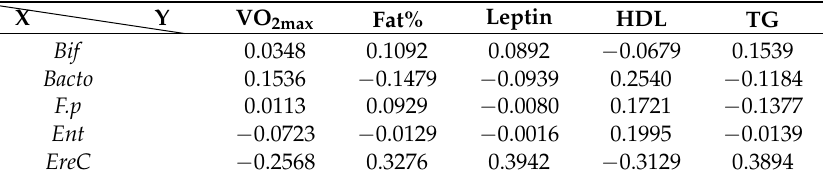
Table 4. The regression weights of multivariable